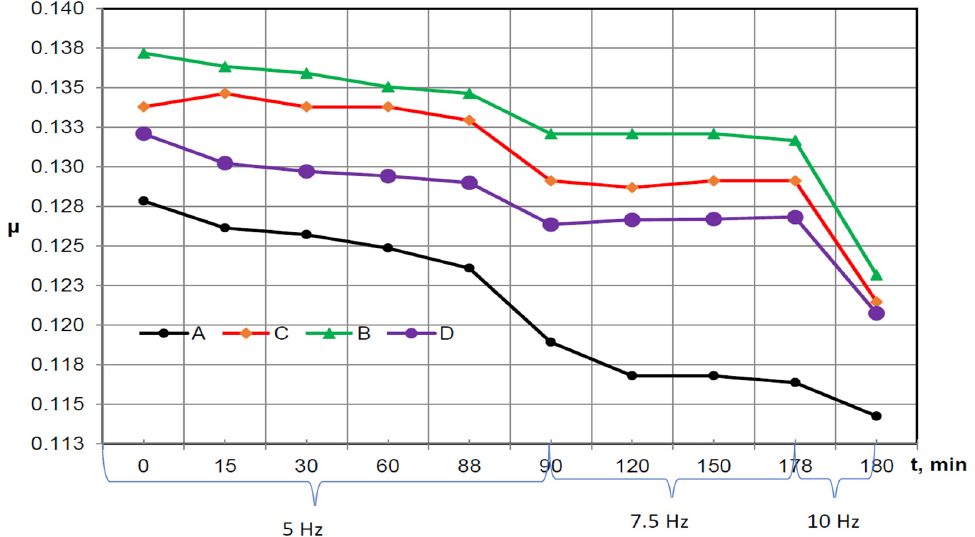
Figure 10. Visualization of changes in the coefficient of friction with time for individual friction pairs with constant load and variable reciprocating frequency (Samples: cast iron (A), pure SJA 175 powder (B) and with 5 wt. % (C) and 10 wt. % (D) addition of YSZ powder.